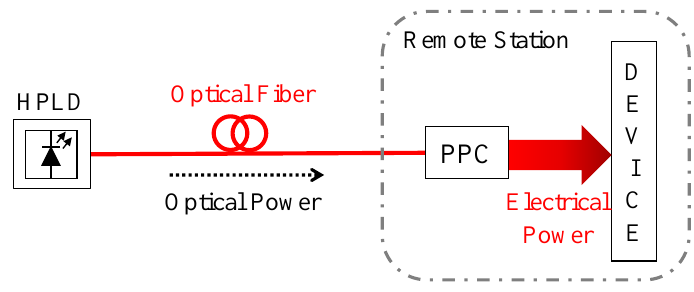
Figure 2. Block diagram of a generic PoF system. HPLD—high power laser diode; PPC—photovoltaic power